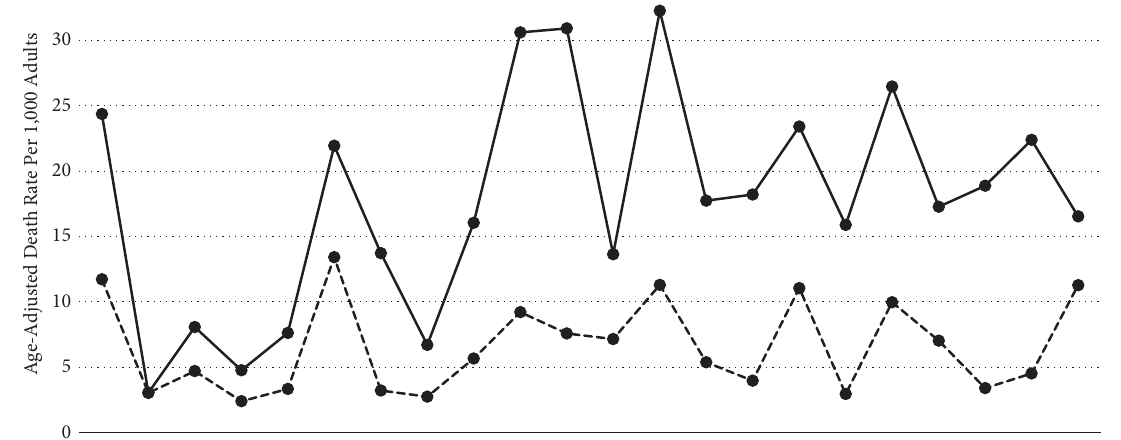
Figure 1: Annual age-adjusted all-cause and liver-related death rates among the Alaska-hepatitis C cohort in Alaska, 1995–2016. † . † Trends are not significant among either group ( P > 0.05).